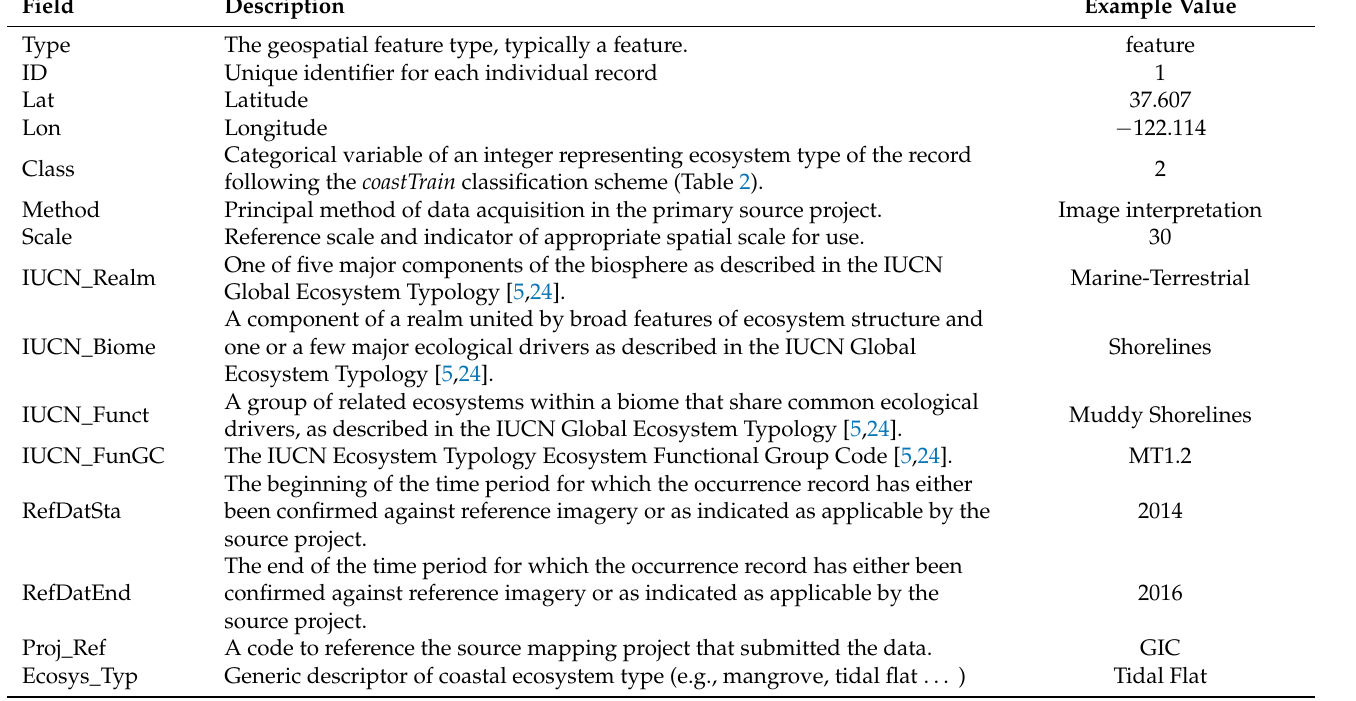
Table 3. Structure of the attribute table for each record in the coastTrain